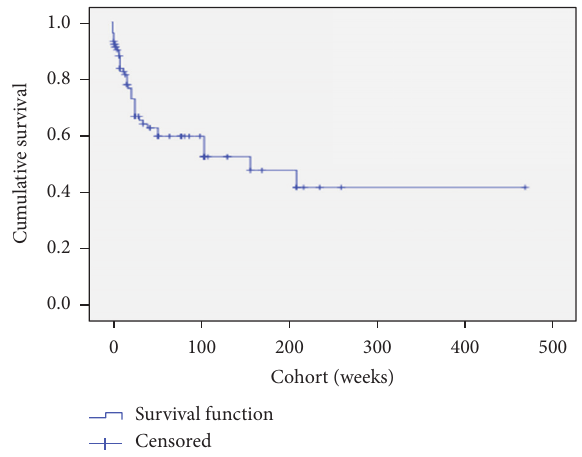
Figure 2: Kaplan-Meier survival of transanal irrigation. In this survival curve the endpoint was defined as patients’ discontinuing TAItherapyduetoperceivedineffectiveness.40patientsreachedthe endpoint with 62 (60.0%) censored at their current duration of use of TAI. The curve demonstrates that a significant proportion of the cohort continue with the therapy.